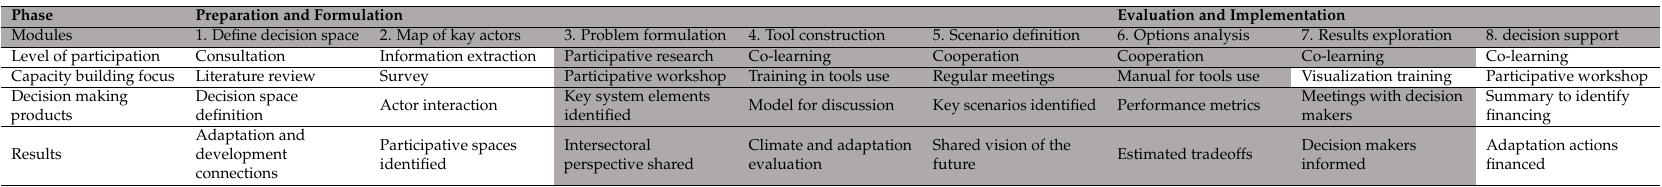
Table 1. Standard Robust Decision Support (RDS) methodology. Source adapted from [15]. The shaded area represents the steps implemented in this